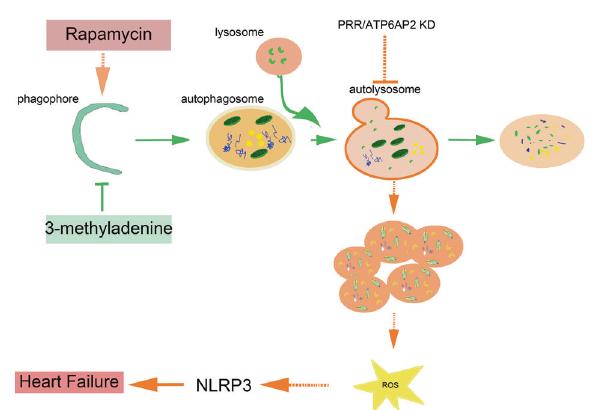
Fig. 8 Working model. ATP6AP2, maintaining lysosomal acidi fi ca- tion function. When ATP6AP2 was knockdown, cardiomyocyte autophagic fl ux and mitophagy were blocked. Further leads to the accumulation of dysfunctional mitochondria, increasing reactive oxygen species (ROS), or mitochondrial ROS. Meanwhile, accumu- lated ROS activates the NLRP3 in fl ammasome and leads to heart failure. Promoting autophagosome formation via Rapamycin increase NLRP3 activation in shR-ATP6AP2-transfected cardiomyo- cytes. Conversely, slowing autophagy initiation by 3-MA partially reduces ROS and activation of NLRP3 in shR-ATP6AP2-transfected cardiomyocytes. Green solid arrows show the normal autophagic fl ux. Arrows in dotted orange indicate that knockdown of ATP6AP2 gene blocks autophagic fl ux, accumulated undigested mitochondria trigger ROS and